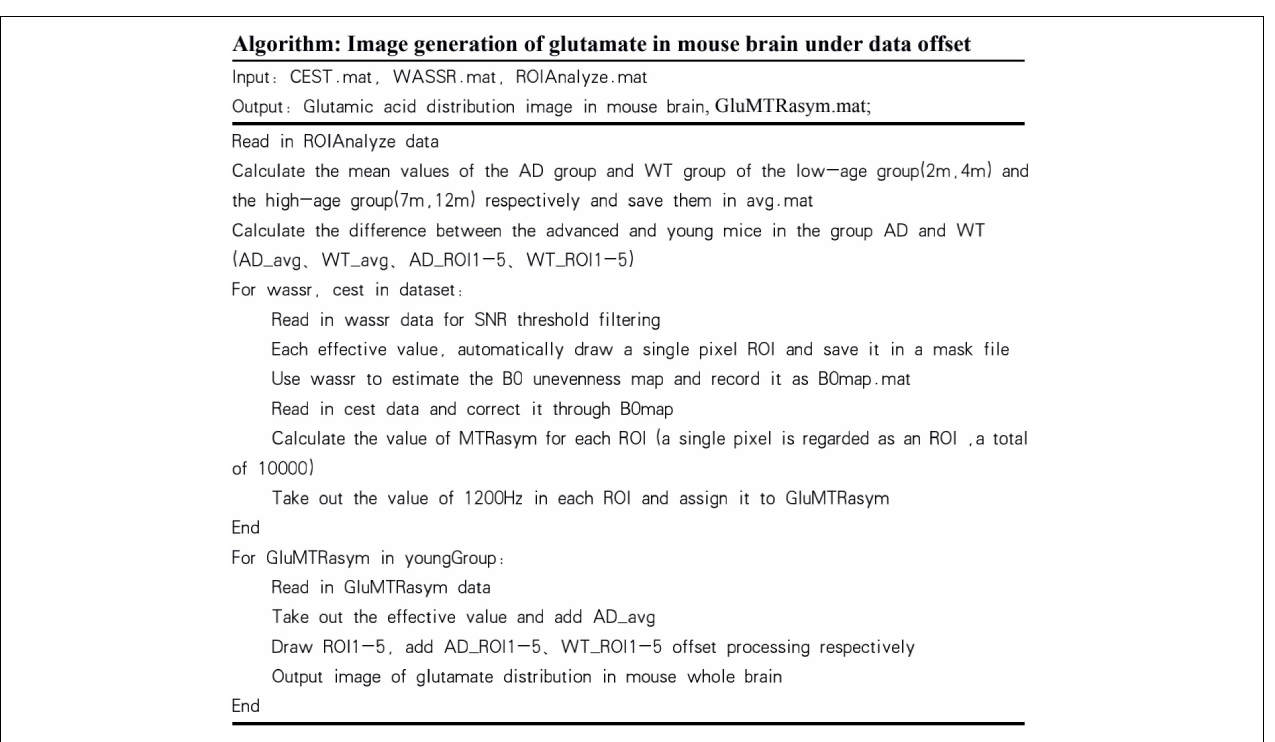
FIGURE 8 | Algorithm about data offset for glutamate